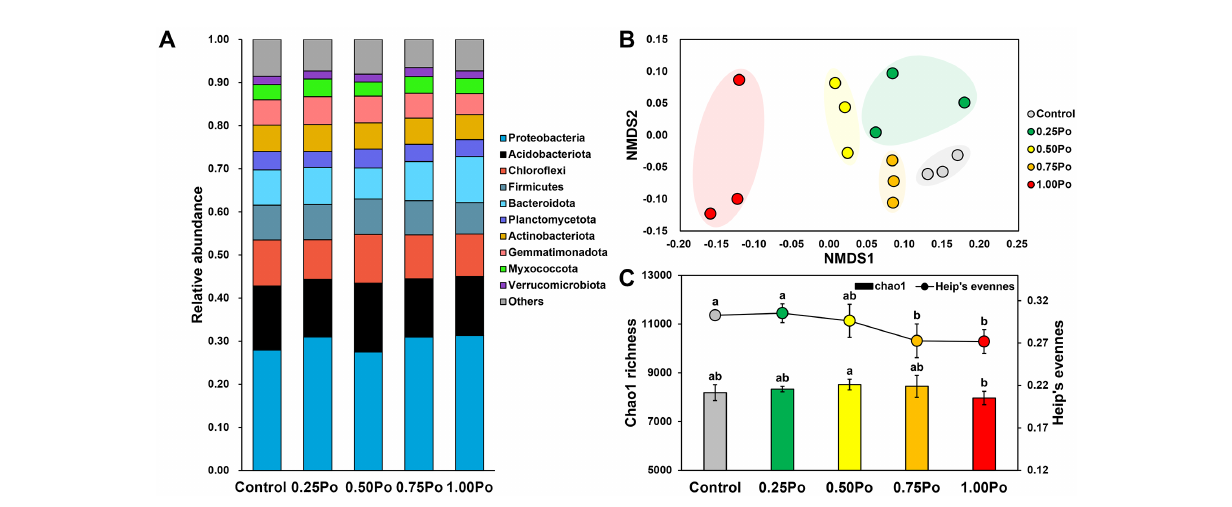
FIGURE 1 Taxonomic composition of the bacterial community under different treatments (A) . NMDS plots show the variation in the bacterial community (B) . Chao1 richness (bar plot) and Heip’s evenness (point plot) of the bacterial community under different treatments (C) . Bars with different letters (shown above each) are significantly different ( p < 0.05) as revealed by the Kruskal–Wallis rank-sum